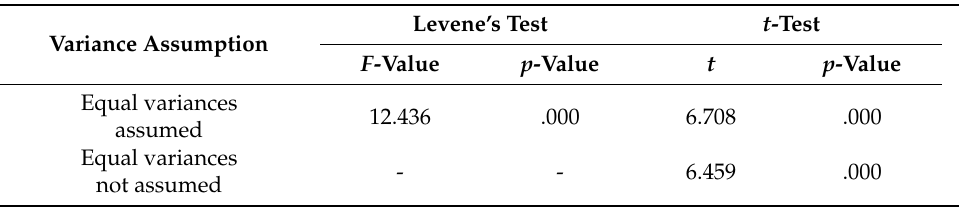
Table 2. Statistical testing between TLC